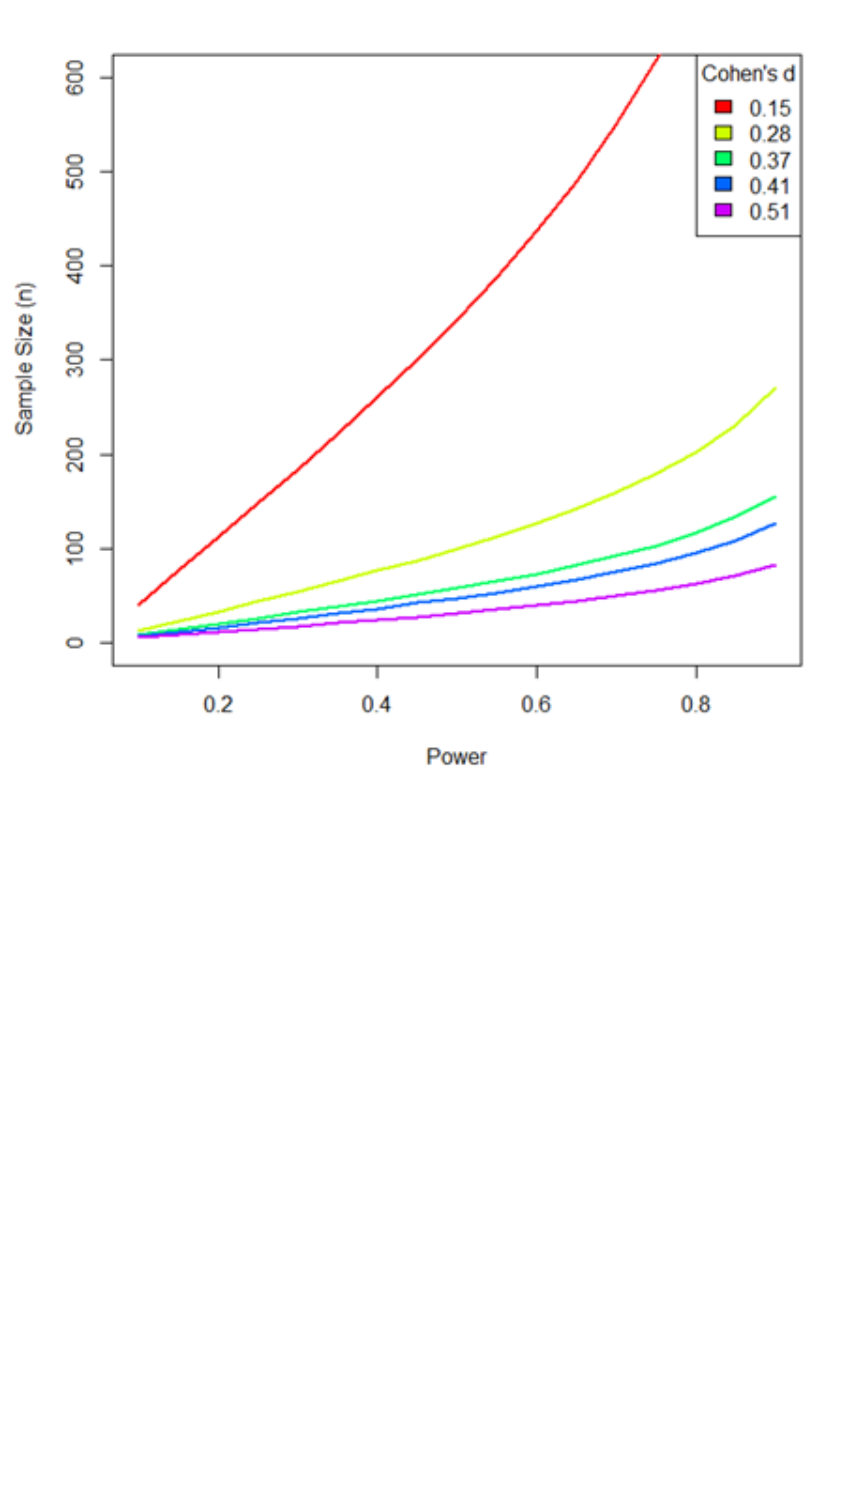
Figure A1.1 Plot of necessary sample sizes given desired statistical power, over a range of observed effect sizes from the field experiment (Cohen’s d), at significance level